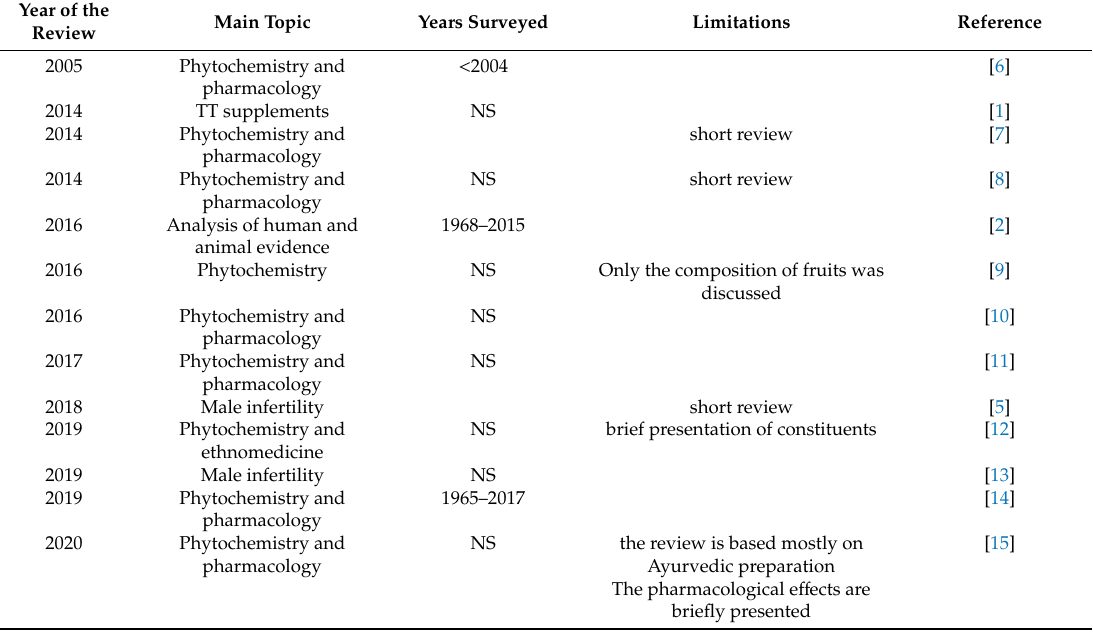
Table 1. Previous